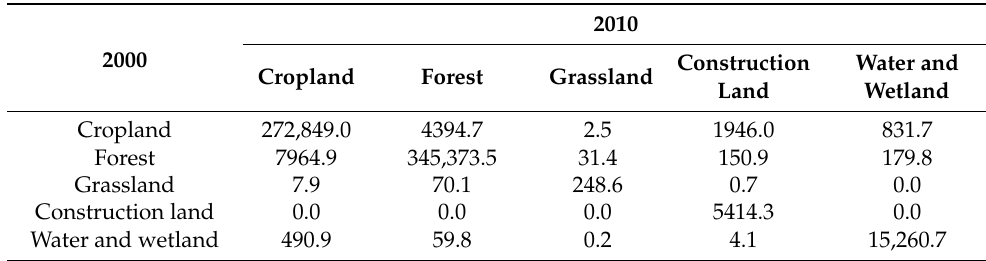
Table A3. The transfer matrix of land-use changes in the Mekong River Basin from 2000 to 2010 (km 2 ).